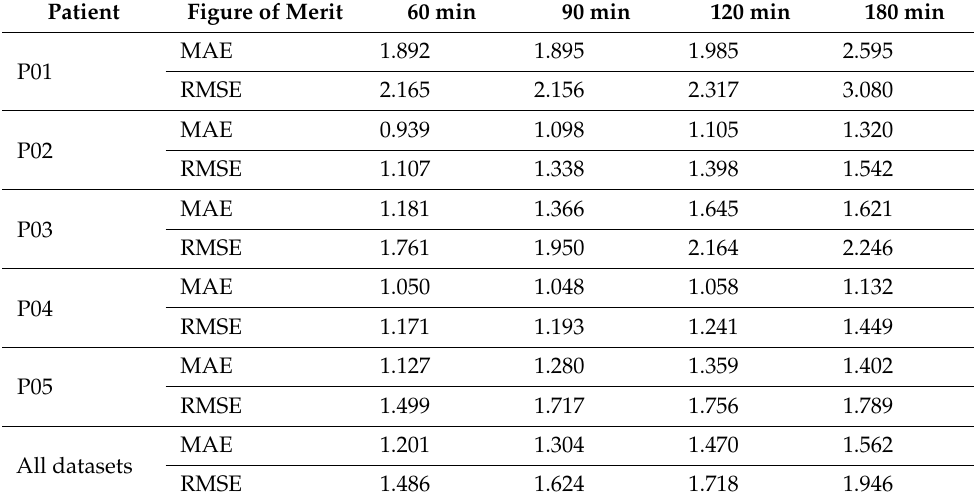
Table 4. Root mran square error (RMSE) and mean absolute error (MAE) results for the five patients with the area under the curve and delay from basal (AUC-DFB) version on four horizons, all values in mmol/L.